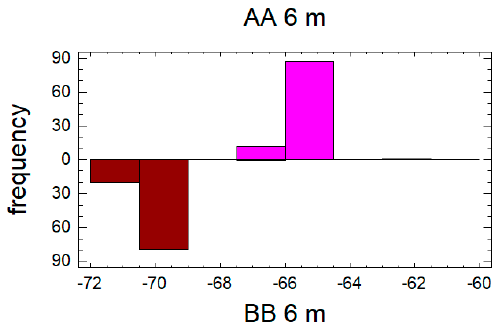
Figure 8. Histogram for reading distance 6 m.